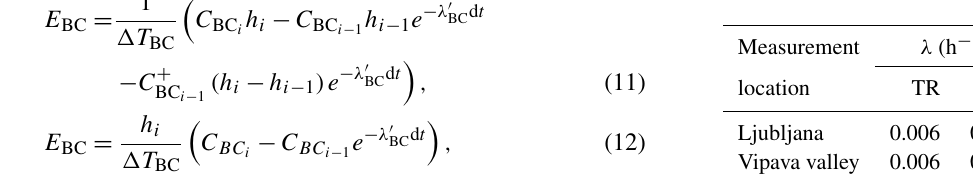
Table 3. Summary of temporal and spatial decay constants selected for the modelled Ljubljana and Vipava valley